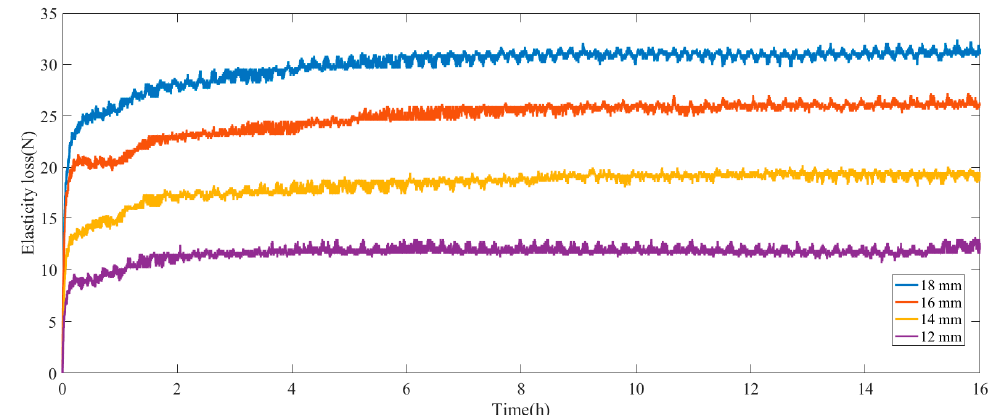
Figure 6. Distribution of load loss with time under different initial loads.